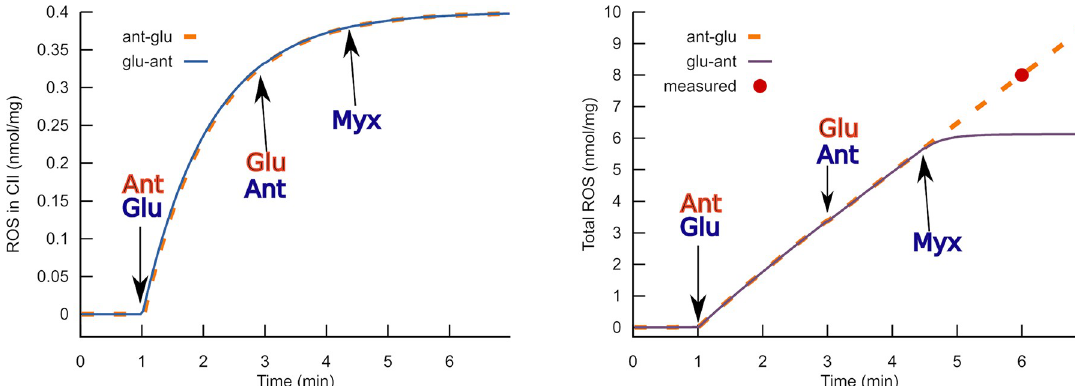
Fig 5. Simulated ROS production response of complexes II (A) and III (B) to combinations of antimycin, glutamate, and myxothiazol. The action of antimycin simulated as a block of ubiquinone binding and dissociation in the N-center of complex III (rate constants of these reactions are 0). Myxothiazol blocks ubiquinol binding in the Qo-center of complex III (corresponding rate constant is 0). Glutamate activates complex II as described in the Introduction. The orange and blue curves simulate different orders of additions. Orange: glutamate is added before antimycin, blue: antimycin is added before glutamate. These simulations qualitatively reproduce a direct record of H 2 O 2 accumulation varying the order of addition of glutamate and antimycin, as shown in Fig 5 of [29]. The code, initial values and rate constants corresponding to this simulation is available at https://github.com/seliv55/cell_mito/tree/fig6.